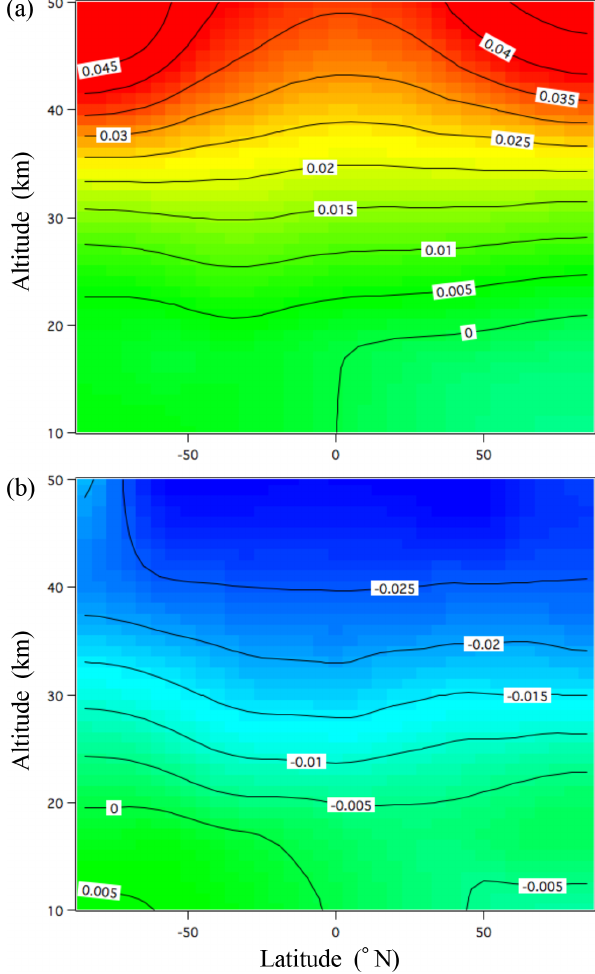
Figure B3. (a) Annual mean meridional distribution of AoA trend (yryr − 1 ) calculated using the updated SOCRATES model for the weakened-BDC simulation. (b) Same as in panel (a) but for the enhanced-BDC